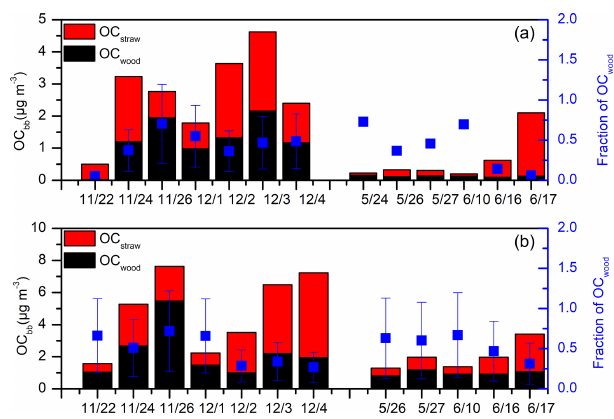
Figure 4. Concentrations of OC from softwood (OC wood ) and OC from straw (OC straw ) at IAP (a) and PG (b) and variations of OC wood